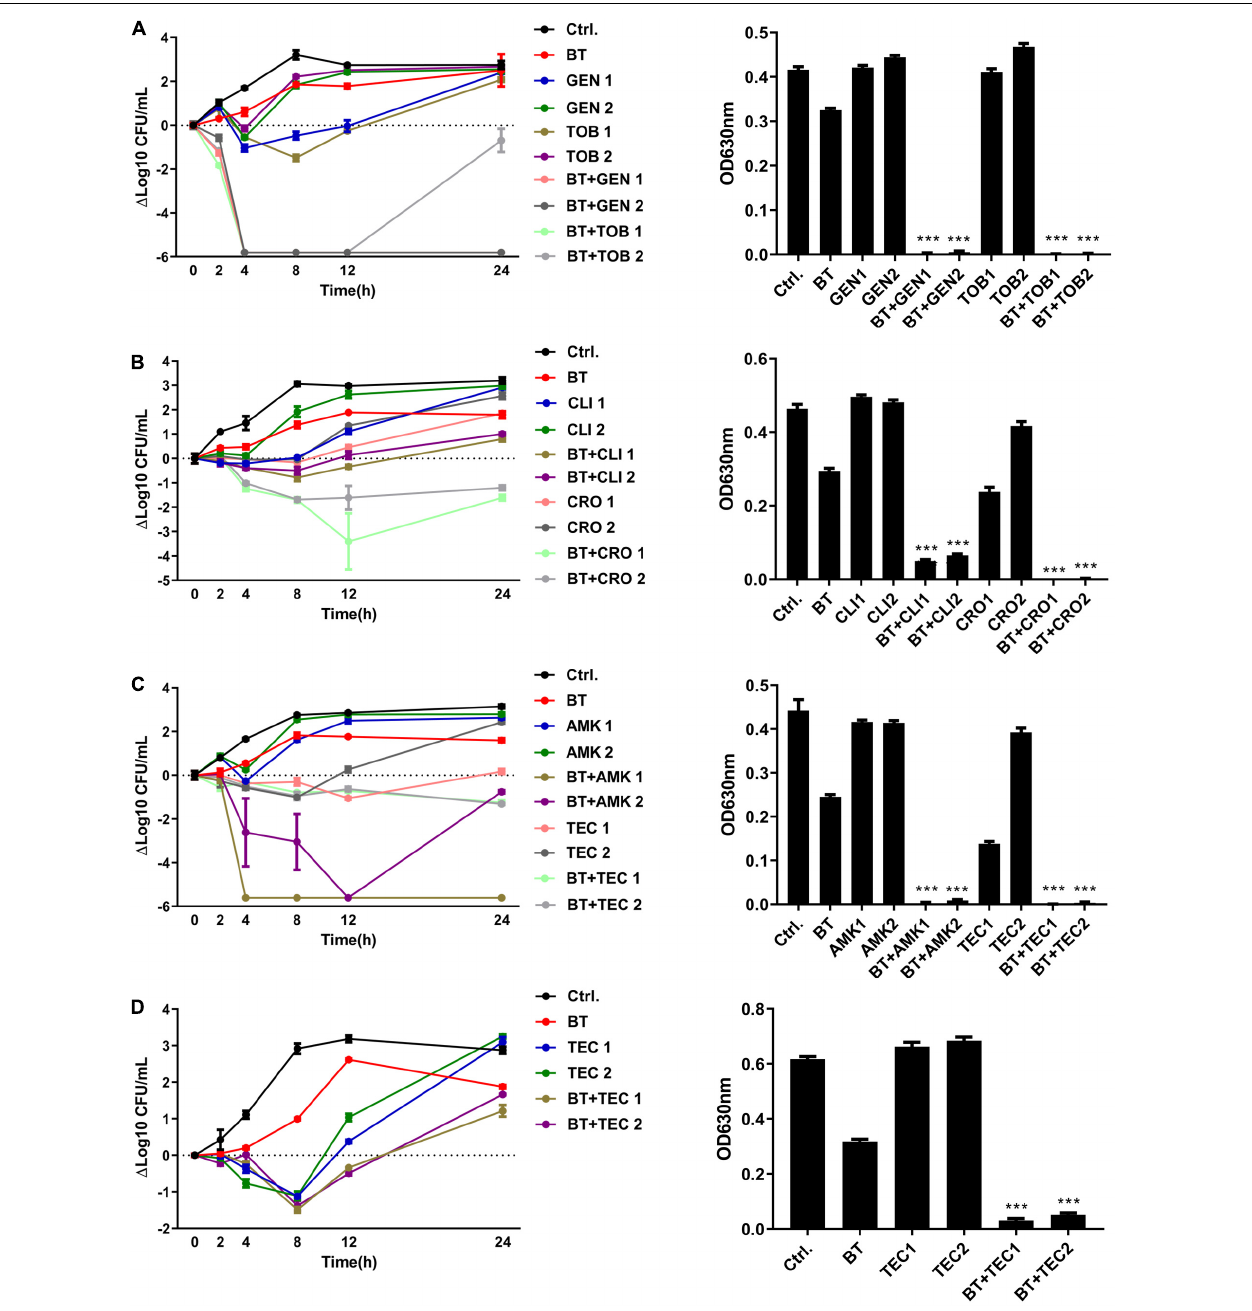
FIGURE 5 | BT enhanced antimicrobial effects of antibiotics against Enterococcus . (A) BT + GEN/TOB or (B) BT + CLI/CRO or (C) BT + AMK/TEC against E. faecalis ATCC 29212; (D) BT + TEC against E. faecium U101. BT: 1 µ g/mL for E. faecalis and 0.5 µ g/mL for E. faecium , GEN1: 8 µ g/mL, GEN2: 4 µ g/mL, TOB1: 8 µ g/mL, TOB2: 4 µ g/mL, CLI1: 2 µ g/mL, CLI2: 1 µ g/mL, CRO1: 8 µ g/mL; CRO2: 4 µ g/mL, AMK1: 32 µ g/mL, AMK2: 16 µ g/mL, TEC1: 0.25 µ g/mL, TEC2: 0.125 µ g/mL. Left panel: Time-kill curves of the combinations of BT plus antibiotics. Y -axis represents the (cid:49) log10 CFU/mL at each time point. Dotted line indicates the baseline of (cid:49) log10 = 0. Right: Turbidity of the culture suspension (A 630 ) at the time point of 24